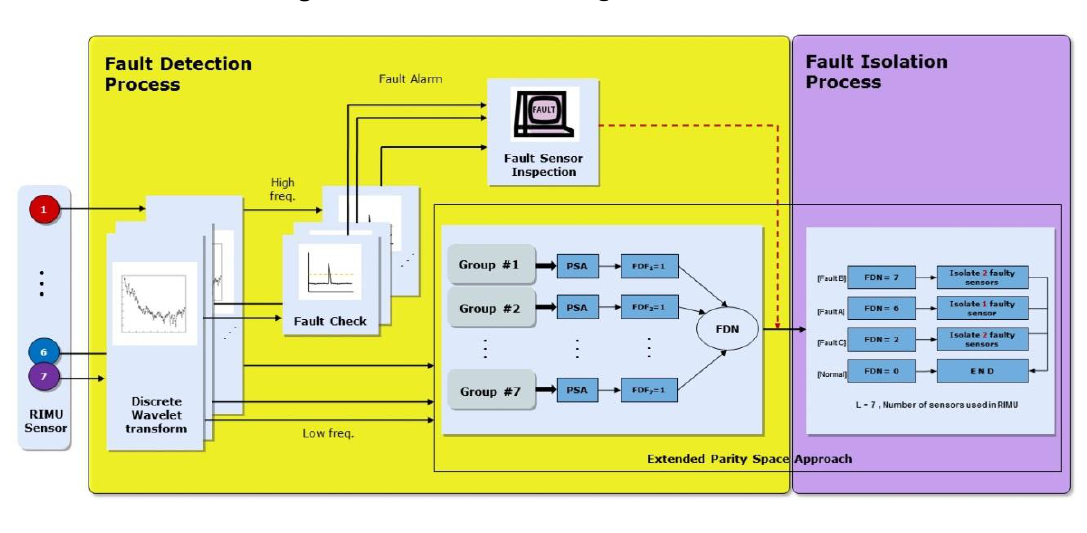
Figure 8. FDI scheme using modified EPSA.